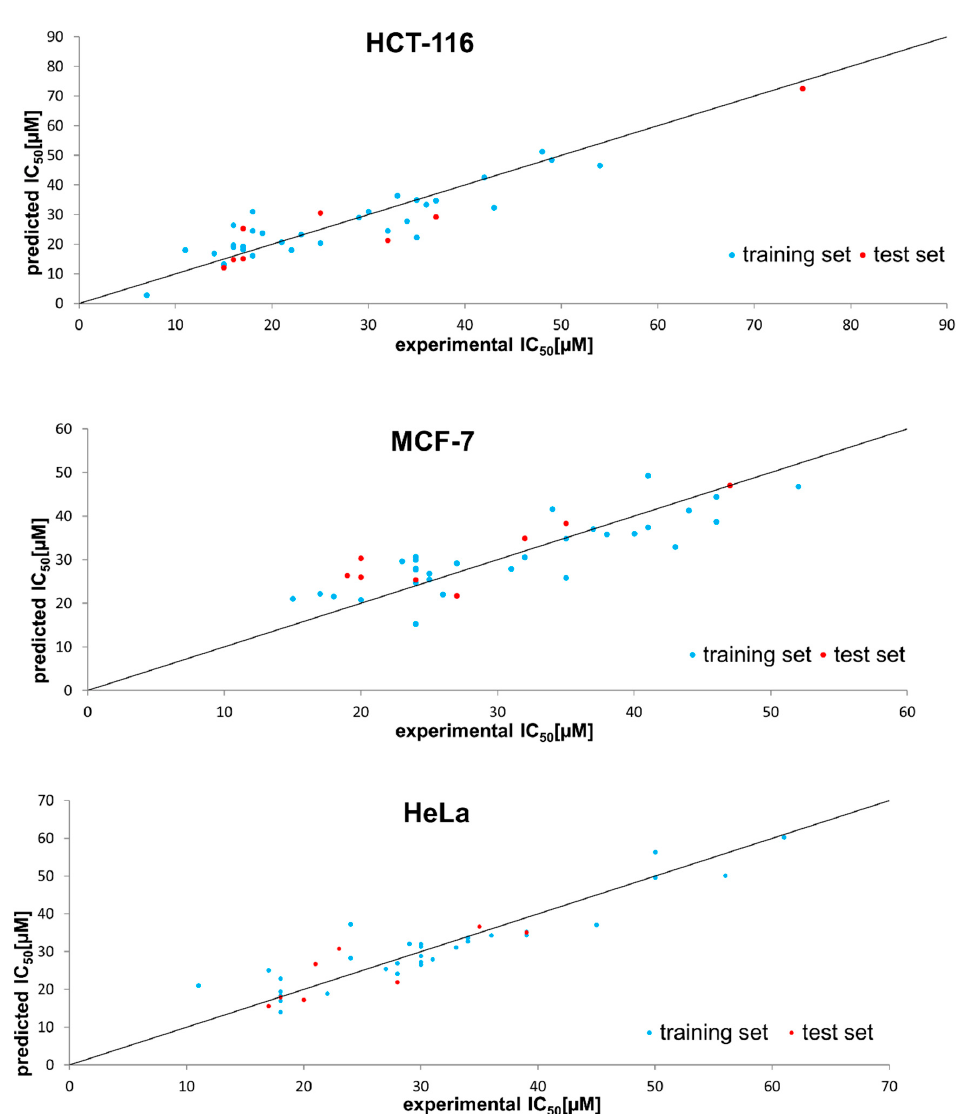
Figure 3. Scatter plot of experimental IC 50 values versus predicted IC 50 values of the training set (blue) and test set (red).